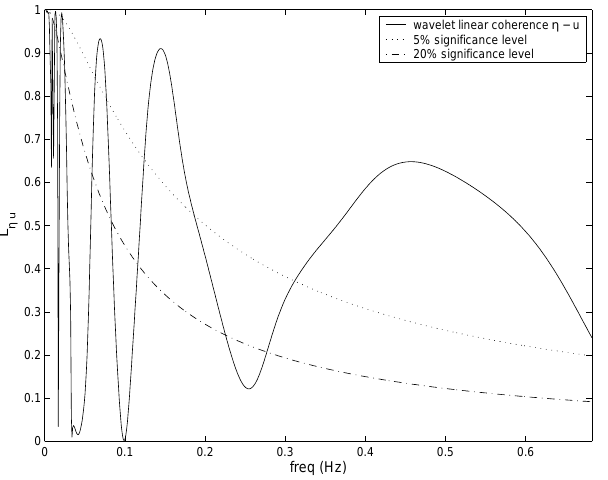
Fig. 6. Wavelet linear coherence of the wave elevation η and the wind velocity fluctuations u estimated over the period from b = 200 δt to b = 299 δt ( m = 100), compared with the 5% and 20% significance levels.